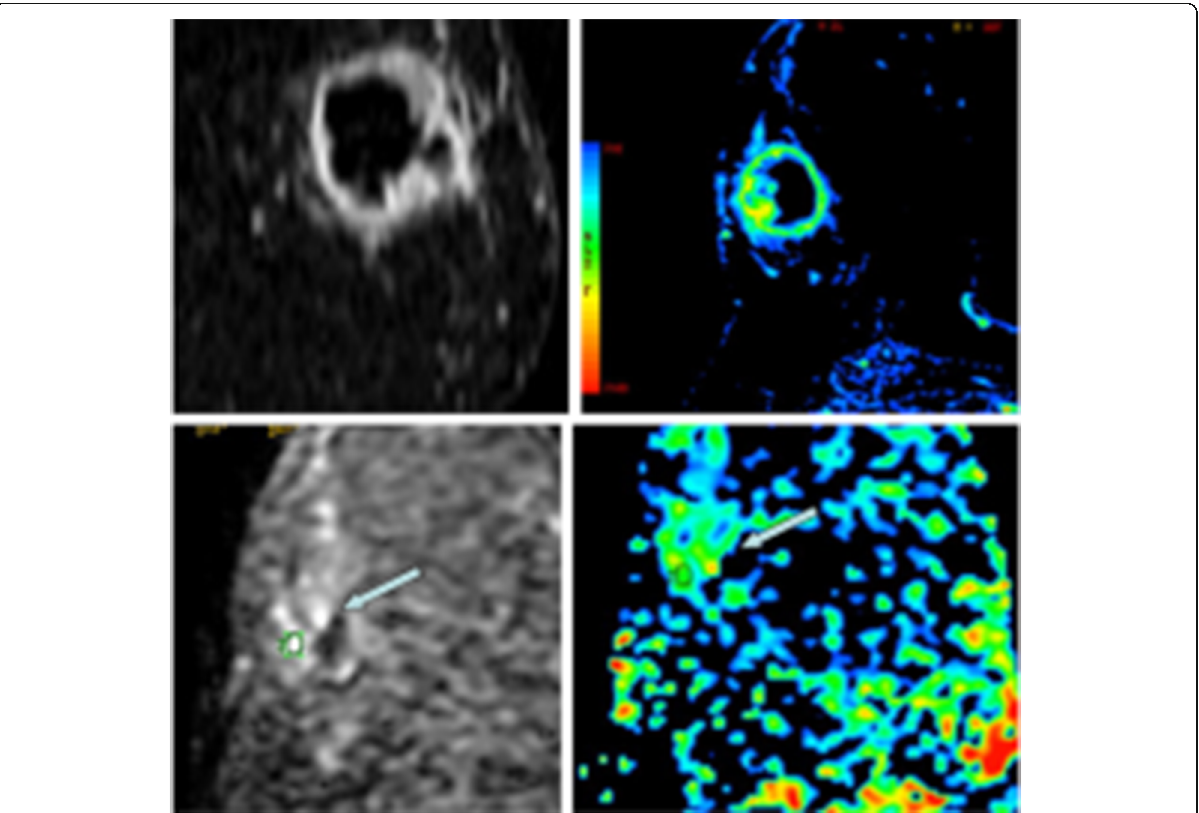
Fig. 13 DW image and a color map of a large breast tumor. Due to the necrosis of the tumor in the ring shown, the diffusion distribution is limited